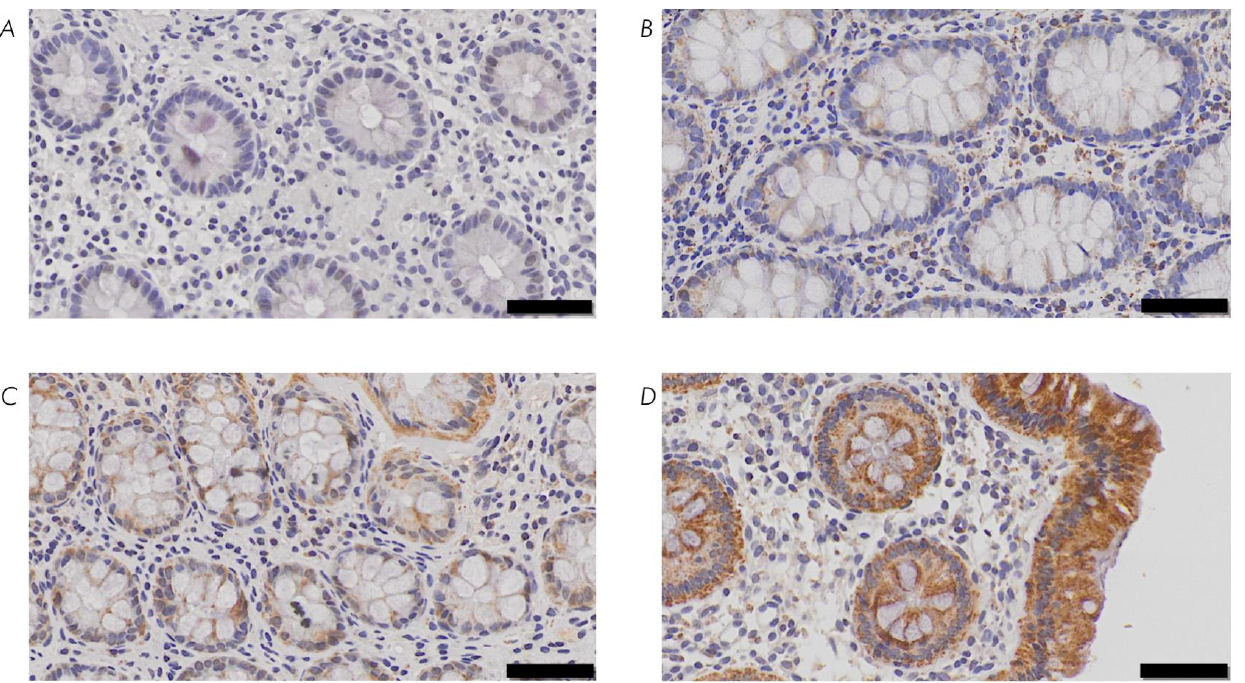
Figure 2. Assessment of staining intensity. ( A ) 0 = no staining (case number 36677: adult with Crohn’s disease; biopsy of the ascending colon stained with cystathionine- γ -lyase (CSE) antibody), ( B ) 1 = weak staining (case number 21480: child with Crohn’s disease; biopsy of the ascending colon stained with cystathionine- γ -lyase (CSE) antibody), ( C ) 2 = moderate staining (case number 10145: adult from control group; biopsy of the ascending colon stained with 3-mercapto-sulfurtransferase (3-MST) antibody), ( D ) 3 = strong staining (case number 13366: child from control group; biopsy of the ascending colon stained with ethylmalonic encephalopathy 1 protein (ETHE1) antibody). Scale bar: 50 μ m.